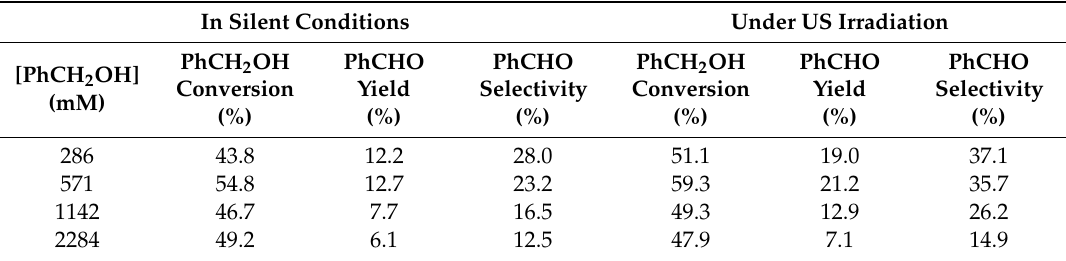
Table 1. Effect of benzyl alcohol concentration on its conversion rate and benzaldehyde